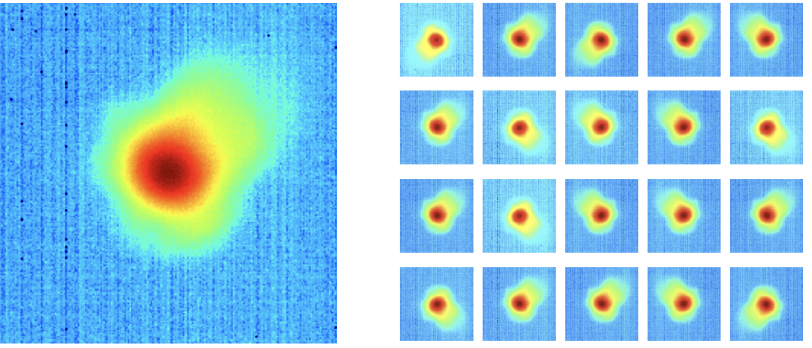
Figure 5. An example of a “bad” pyrometer image ( left ) and the 20 additional images created from it via data augmentation methods ( right